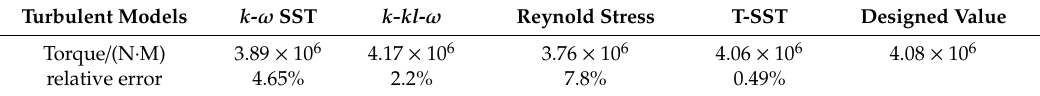
Table 3. Time averaged rotor torque calculated using di ff erent unsteady turbulence models. Turbulent